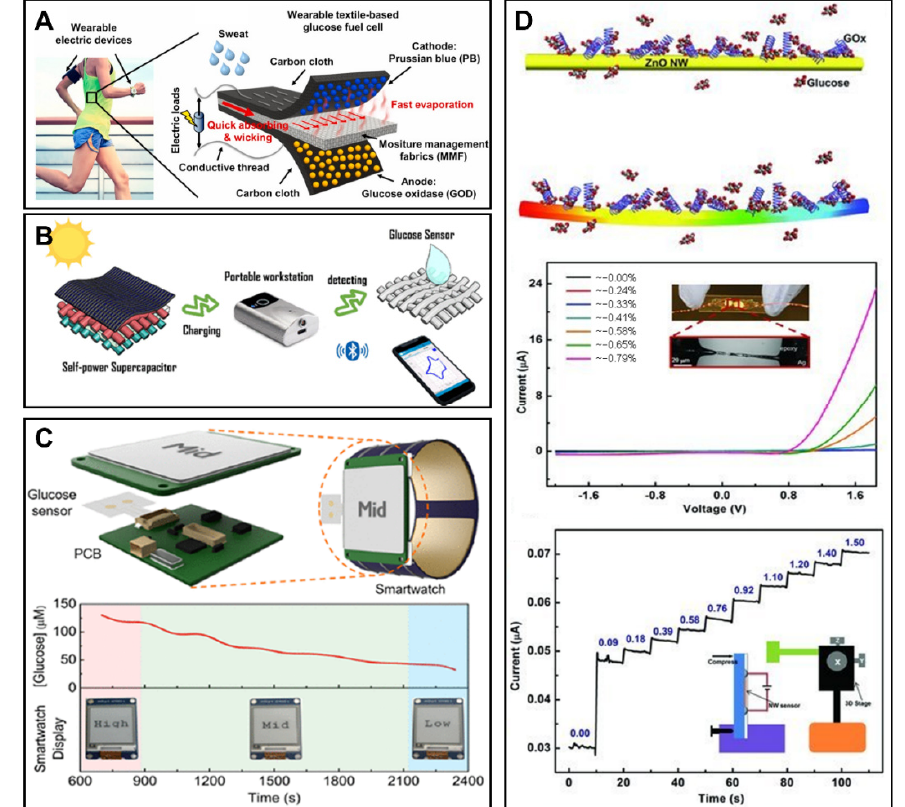
Figure 5. The novel energy supply technology for glucose monitoring. ( A ) The schematic view of the wearable and flexible textile-based glucose biofuel cell based on moisture management fabric. Reprinted with permission from Ref. [120] Copyright (2020) Elsevier. ( B ) The illustration of the wearable energy storage and flexible glucose detection based on self-power supercapacitor. Reprinted with permission from Ref. [44] Copyright (2020) American Chemical Society. ( C ) Schematic illustrations of the integrated and self-powered smartwatch, and the real-time monitoring of sweat glucose. Reprinted with permission from Ref. [125] Copyright (2019) American Chemical Society. ( D ) Illustration of the zinc oxide-based piezotronics for the enhanced self-powered detection of glucose. Reprinted with permission from Ref. [126]. Copyright (2013) Wiley.